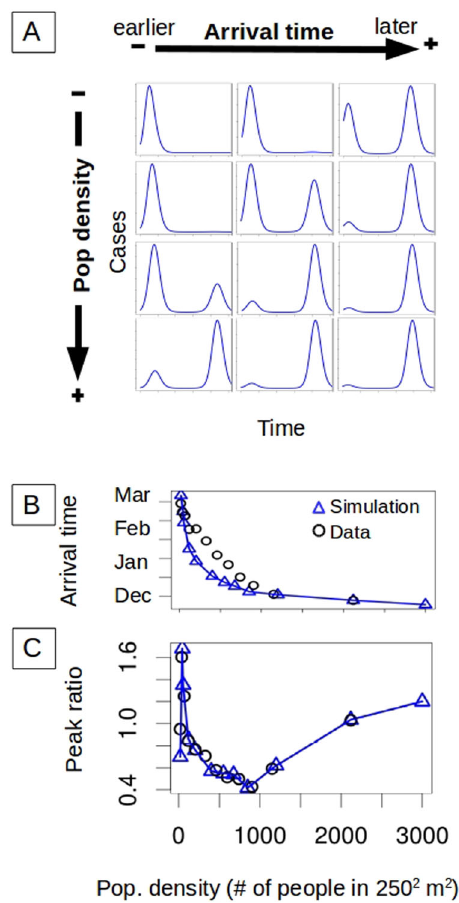
Fig. 3 Deterministic SIR (susceptible – infected – recovered) dynamics and successive epidemic size. A The temporal incidence of a unit is shaped by human density directly, but also indirectly via the arrival time of the fi rst imported infection (the y-axis is normalized by the maximum value of cases for better visualization). The temporal dynamics are simulated with a deterministic SIR model with a seasonal transmission rate. For a given arrival time, the size of the second peak increases with the population density of the unit (top to bottom). The earlier the fi rst infection reaches the unit, the smaller the size of the second peak (left to right). B Importantly, denser units are infected earlier (data: black circles). The blue triangles are used as input to the model to specify arrival time and therefore initial conditions in a given unit (with an exponential decay curve capturing the observed trend). The earlier importation of infection in denser units implies two opposite effects of population density on relative peak size (demonstrated in A ). C For arrival times similar to those observed in the data, the model simulations (blue triangles) can capture the observed behavior (black circles) of the peak ratio with human density. The results correspond to a partition of the city into 12 groups according to population